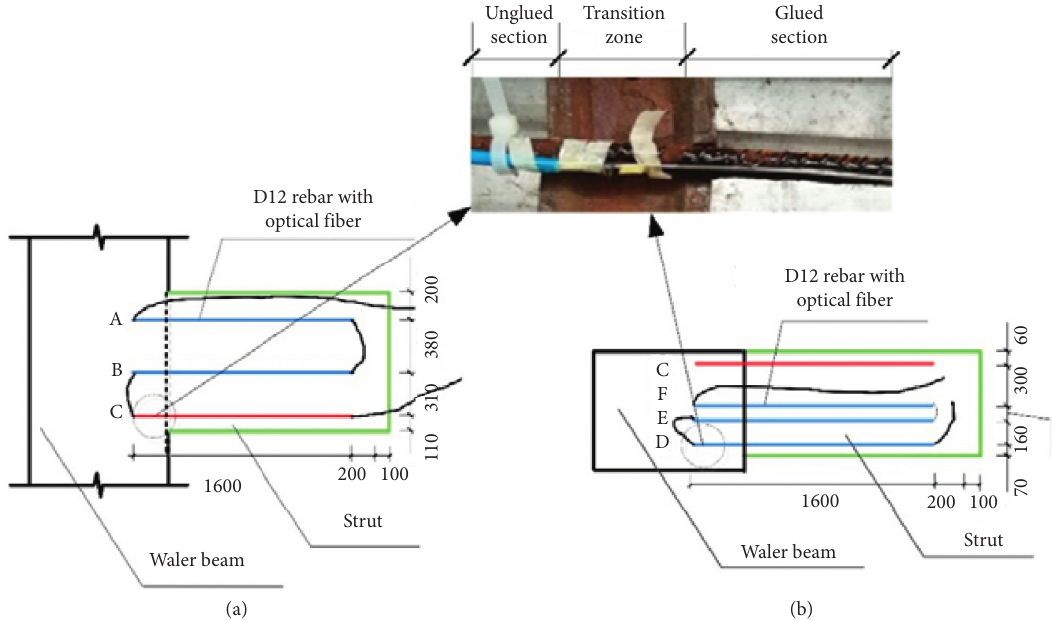
Figure 4: Layout of fibers inside the strut: (a) top view and (b) side view (unit: mm).